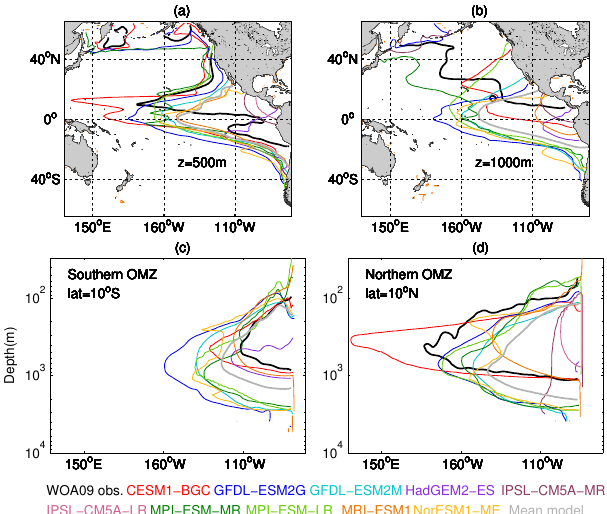
Figure 1. Comparison of the Pacific Ocean oxygen minimum zones (at O 2 = 30mmolm − 3 ) across CMIP5 models (represented by coloured lines – see legend for explanation) and observations (solid black lines) during the historical period 1960–1999. The grey line represents the multi-model mean, calculated using the weights in Table A1. Panels (a) and (b) show the OMZs at depth 500 and 1000m, while panels (c) and (d) show longitudinal depth sections of the Southern and Northern tropical OMZs, at latitude 10 ◦ S and 10 ◦ N. Depth scale (m) is logarithmic. The model HadGEM2-CC (not shown) shows results similar to